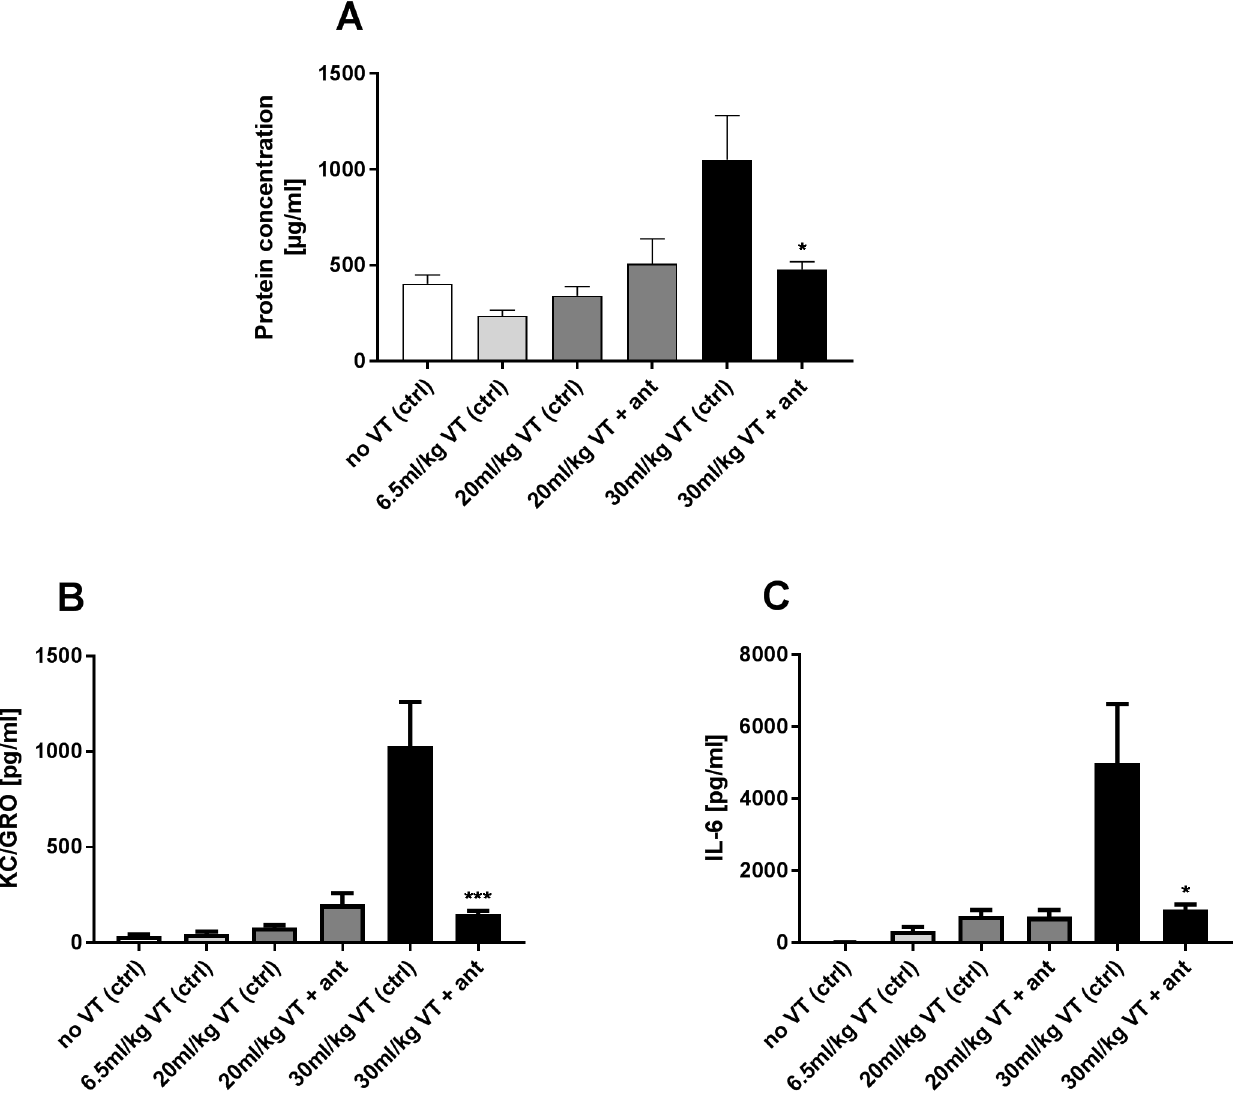
Fig 6. TRPV4 antagonist effect on ventilation induced cytokine release and protein concentration in BALF. Balb/c mice were anesthetized and mechanically ventilated (VT) in presence or absence of the TRPV4 antagonist GSK2193874 [90mg/kg] with different ventilation protocols; with tidal volumes of 20 ml/kg and 30ml/kg with a frequency of 75/min and a control group (ctrl) ventilated with a normal tidal volume of 6.5ml/kg and a frequency of 150/min for 3h and a non-ventilated control group (ctrl). (A) Increased protein concentration in BALF was observed at 30 ml/kg ventilation that could be blocked by TRPV4 inhibition (ant). (B,C) Increase release of the cytokine KC/GRO and IL-6 after a 30 ml/kg ventilation that could be blocked by TRPV4 antagonism (ant). Data are mean ± SEM; (n = 8); (cid:3) p < 0.05; (cid:3)(cid:3)(cid:3) p < 0.001 vs 30 ml/kg VT control; one-way ANOVA Tukey’s multiple comparisons test).